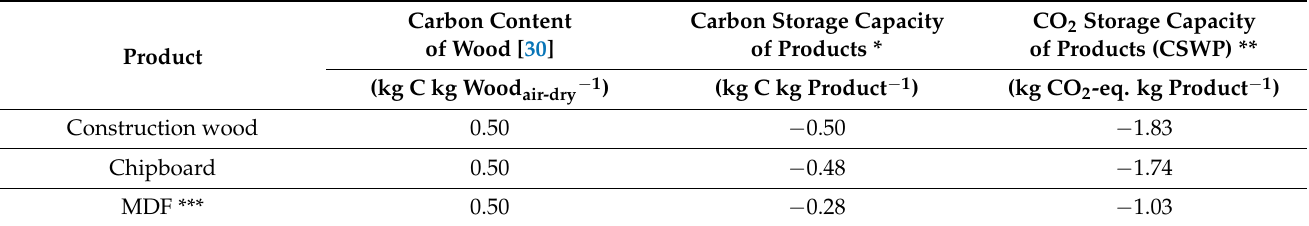
Table 2. Calculation of the mean carbon storage capacity of wood products (CSWP) during a credit period of 30 years (material use